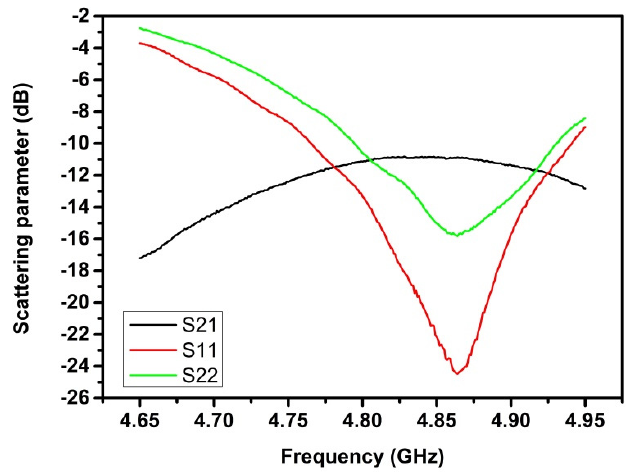
Figure 4. Magnitudes of the scattering parameters S 21 (black line), S 11 (red line) and S 22 (green line) versus the frequency for the microstrip antenna (MSA) used in this work when the distance between antennas was 24 mm. The measurements were obtained under standard laboratory atmospheric conditions.